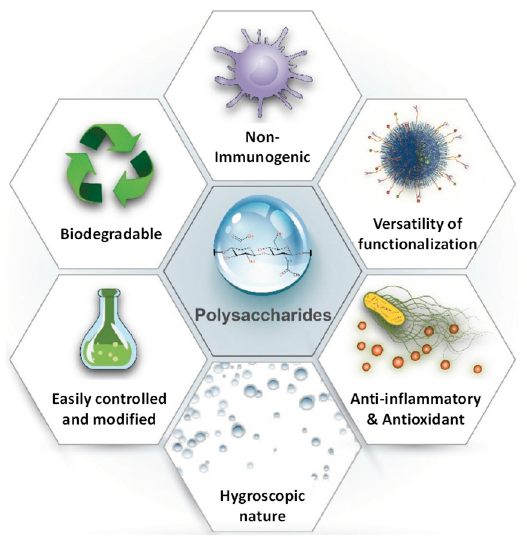
Figure 2. Schematic illustration of the unique physiochemical and biological properties of polysac- charides. Adapted from [38], Wiley, 2018.